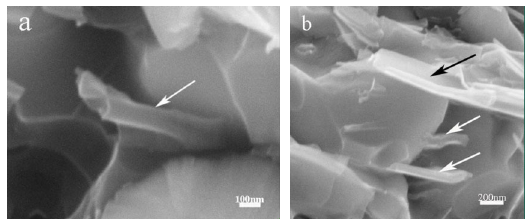
Fig. 5 Fracture surfaces for cermet with 0.5 wt% MWCNT addition: (a) low magnification, (b) high